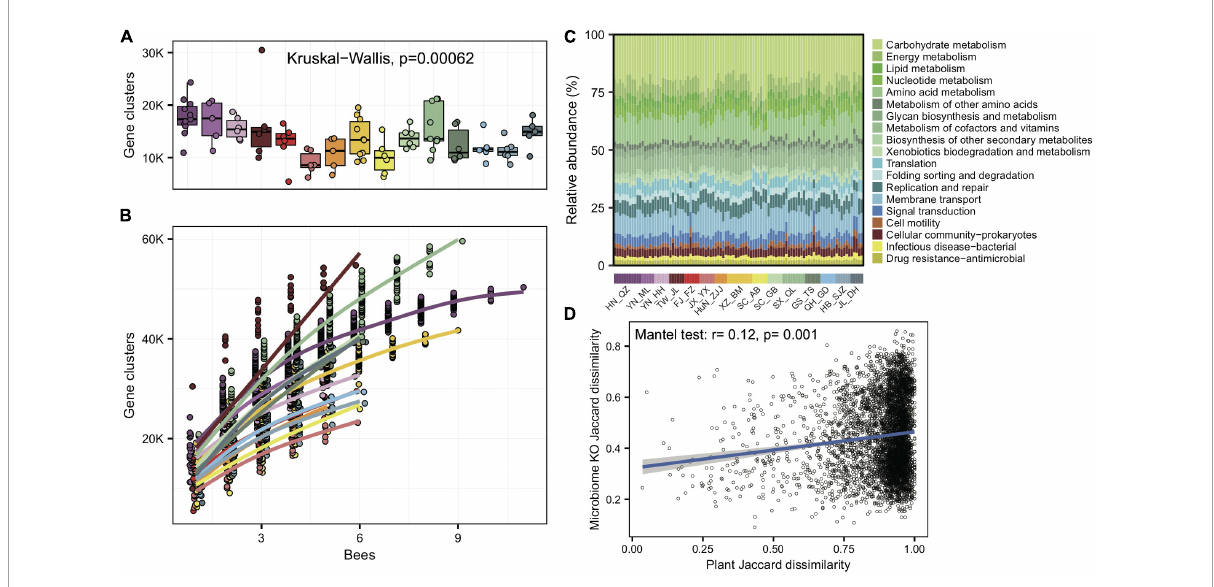
FIGURE3 Significant variations in gene cluster and functional annotation among populations. (A) Gene cluster numbers per gut sample, based on 400 Mb bacteria-mapped reads. (B) Accumulation curves for gene clusters of each population of A. cerana , based on 400 Mb bacteria-mapped reads. (C) Relative abundance of KEGG annotations in each gut sample, based on all bacteria-mapped reads in metagenomes. (D) The Jaccard distances of the gut bacterial KO composition and the pollen composition at the family level were significantly